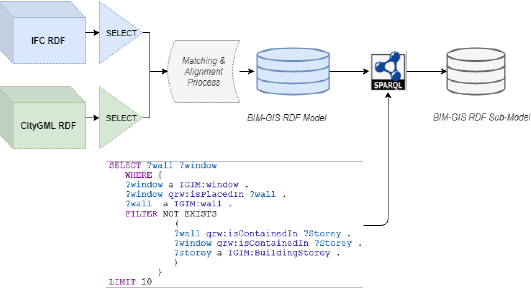
Figure 6: SPARQL Query of BIM-GIS sub-model